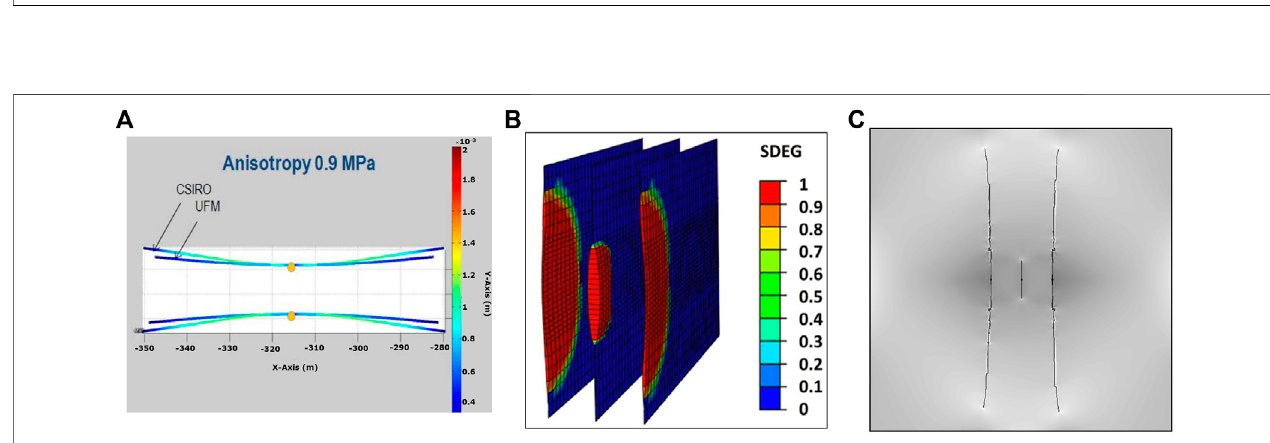
FIGURE 5 | Hydraulic fracture geometries in models with two different treatment schemes. (A) pay zone 2 is solely treated; (B) pay zones 1 and 2 are simultaneously treated.